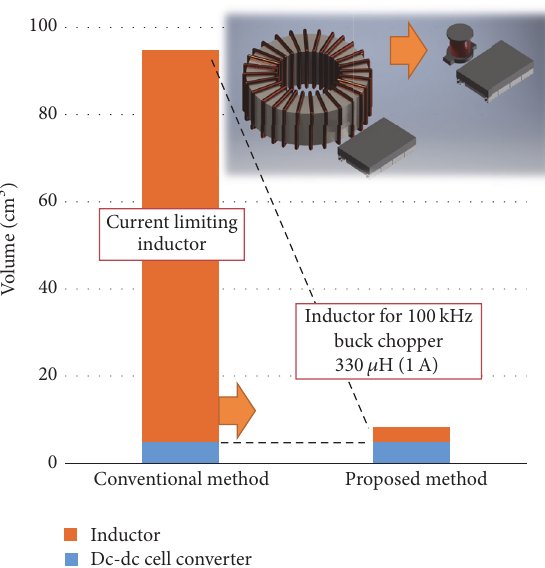
Figure 11: Application effect of active gate controlled SiC power transfer switch to downsize inductor